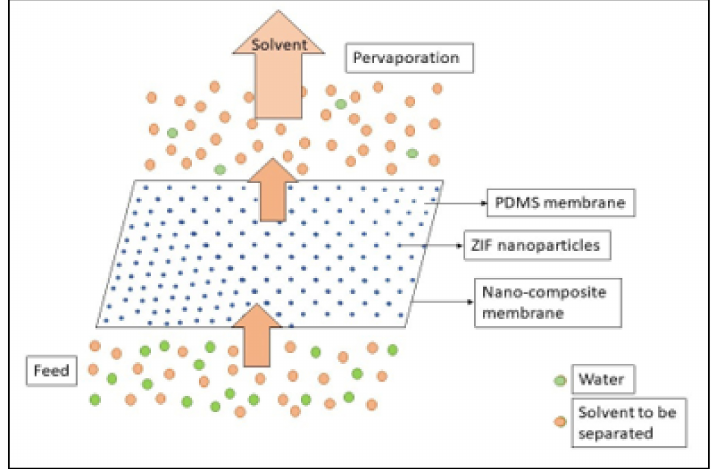
Figure 1. Schematic diagram of pervaporation